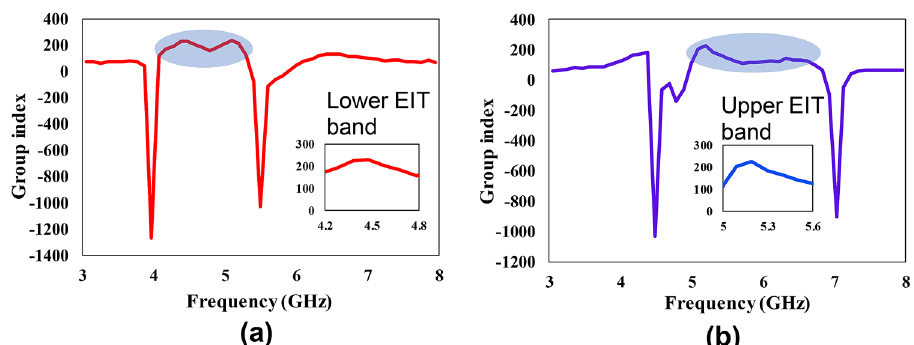
Figure 3. Demonstration of slow wave effect of the proposed EIT-based diplexer in terms of group refractive index. The group refractive index reaches about 200 in the EIT-like bands ( a ) simulated group refractive index for the lower EIT-like band towards port-2. ( b ) the simulated group refractive index for the upper EIT-like band towards